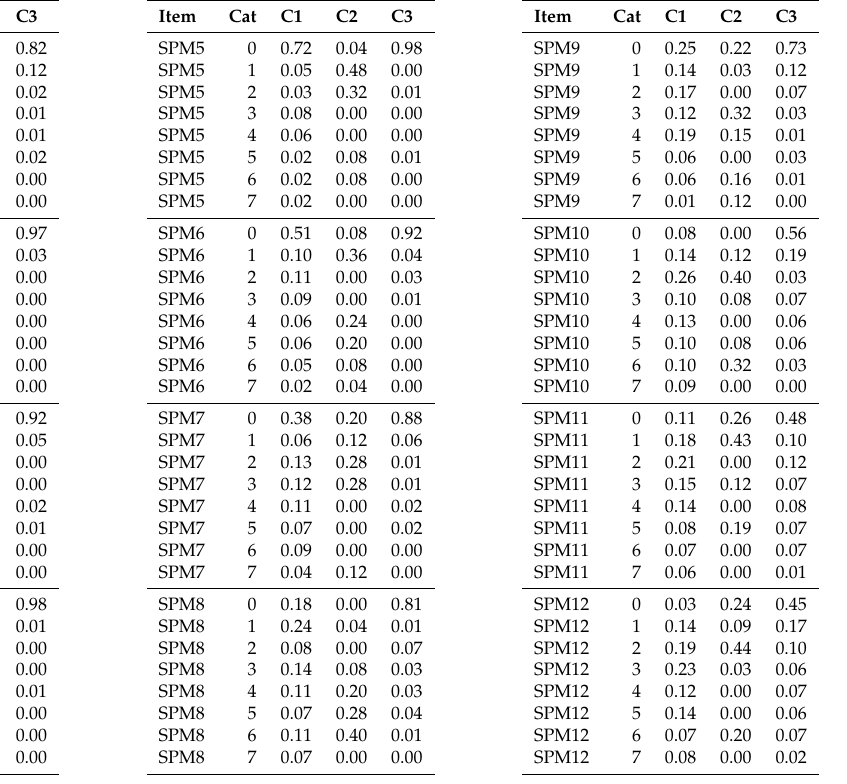
Table A2. SPM-LS polytomous data: estimated item response probabilities and latent class probabilities for best-fitting RLCM with C = 3 latent